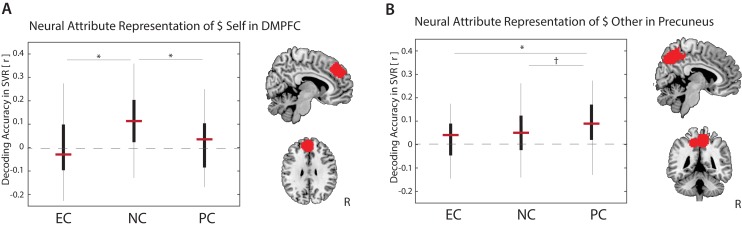
Goal-dependent modulation of neural value encoding in DMPFC ($Self) and Precuneus ($Other) in the altruism task.Panel displays average decoding accuracies for clusters where neural representations of attributes varied across regulation conditions for neural Support Vector Regressions (SVRs) (p<0.001, FWE corrected at cluster-level). Bars represent median estimates; black boxes signify 25–75 percentile, lines illustrate the overall distribution. HC = Health Condition, NC = Natural Condition, TC = Taste Condition, PC = Partner Condition, EC = Ethics Condition, L = left hemisphere, R = right hemisphere.